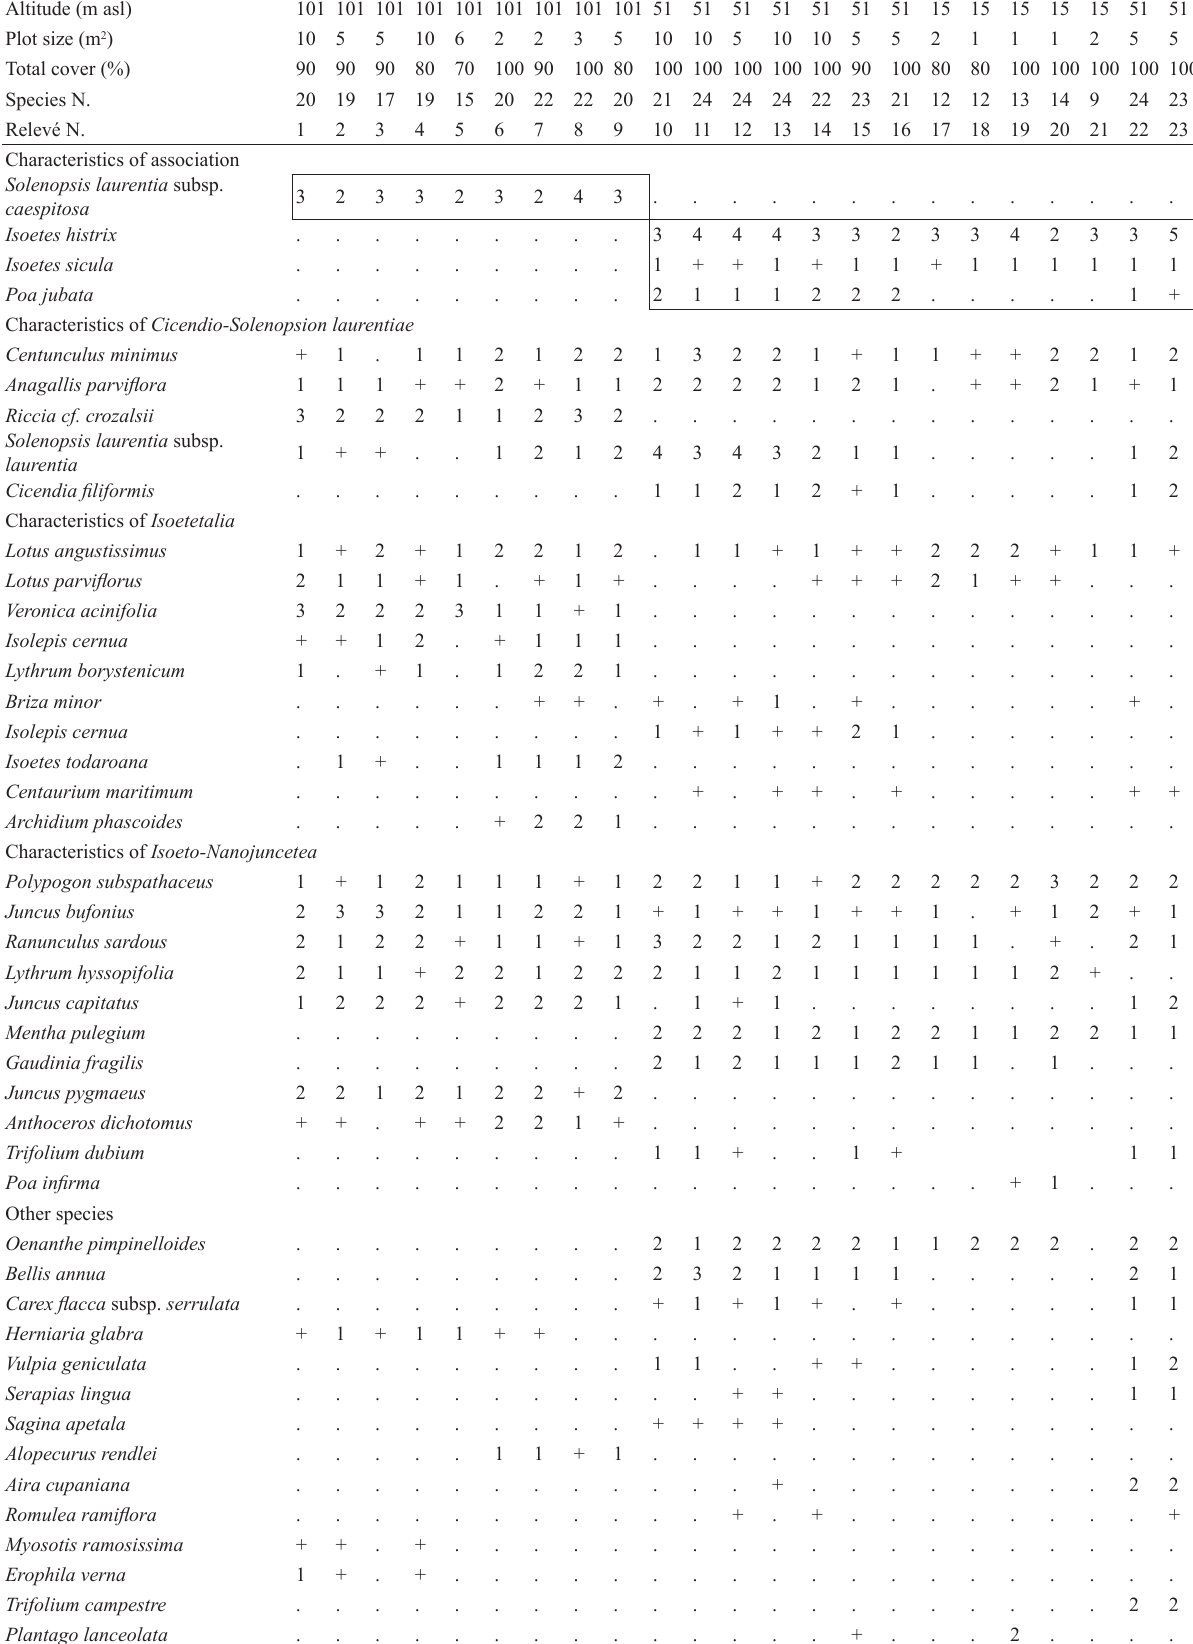
Table 6. Solenopsidetum caespitosae ass. nova (rel. 1-9), Poo jubatae-Isoetetum histricis ass. nova (rel. 10-23) ( Cicendio- Solenopsion laurentiae , Isoetetalia , Isoeto-Nanojuncetea ) Altitude (m asl) Plot size (m 2 ) 10 5 5 Total cover (%) Species N. Relevé N. 1 2 Characteristics of association Solenopsis laurentia subsp. 3 caespitosa Isoetes histrix . Isoetes sicula . . . Poa jubata . . . . . . . . . 2 . . . . . 1 + Characteristics of Cicendio-Solenopsion laurentiae Centunculus minimus + 1 . 1 1 2 1 2 2 1 + + 2 Anagallis parviflora 1 1 1 + + 2 + 1 1 2 1 Riccia cf. crozalsii